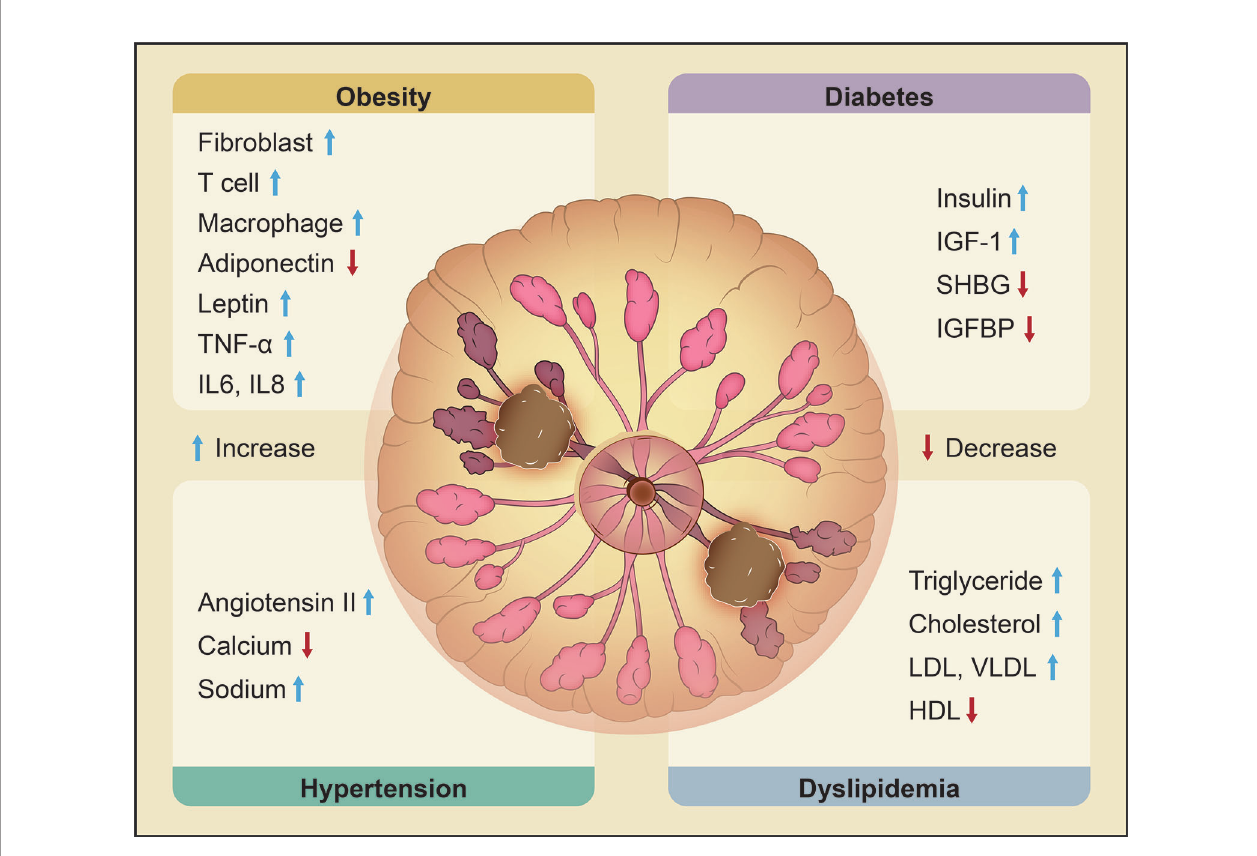
FIGURE 1 | Metabolic syndrome and its molecular changes related to the risk of breast cancer. Obesity, diabetes, hypertension and dyslipidemia are the main components of metabolic syndrome and are all signi fi cantly related to the risk of breast cancer. Obesity increases fi broblasts, T cells, macrophages, leptin, TNF- a , IL-6 and IL-8 and decreases adiponectin. Diabetes is characterized by upregulation of insulin and IGF-1 and downregulation of SHBG and IGFBP. Hypertension is associated with increased ANG II and sodium and decreased calcium. Dyslipidemia leads to high levels of TG, TC, LDL, and VLDL and low levels of HDL. Changes in the expression of these key molecules are correlated with an elevated risk of breast cancer. ( ‘ the blue arrow ’ means increase and ‘ the red arrow ’ means